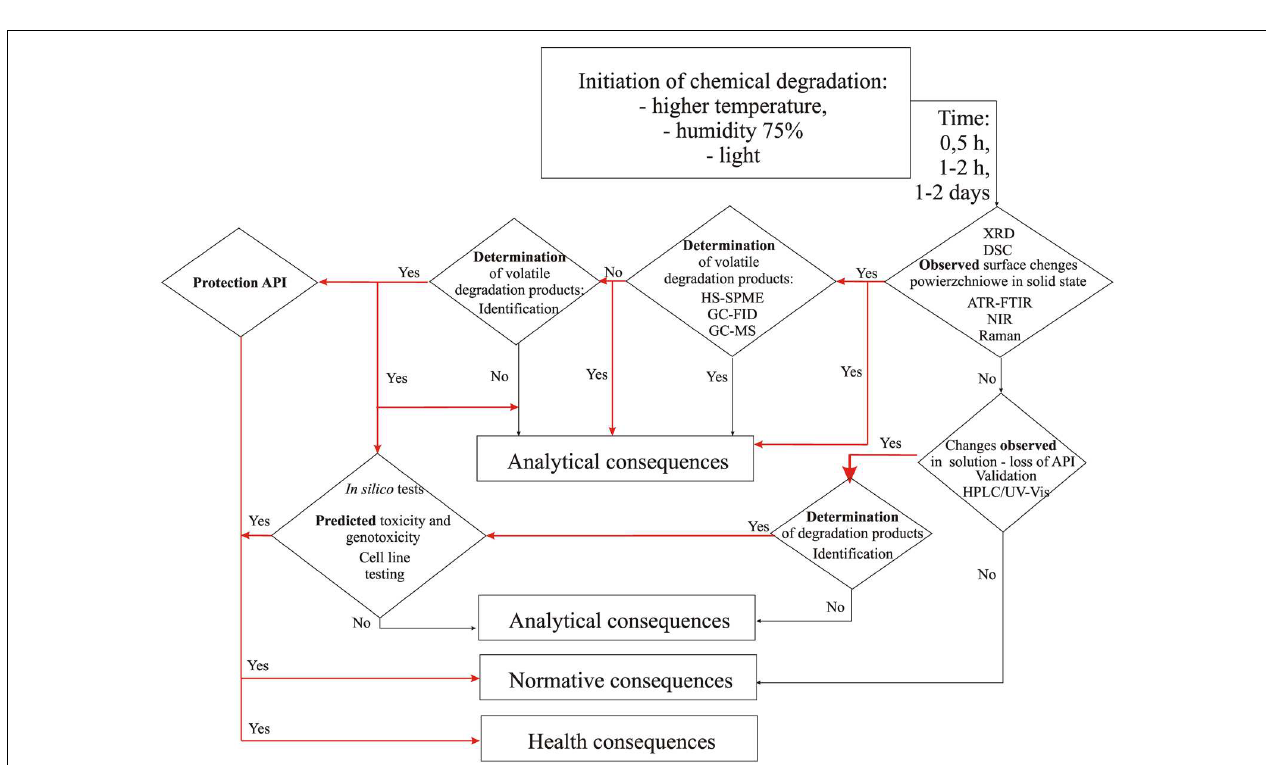
FIGURE 2 | New analytical workflow concerning different consequences of stability testing of APIs.